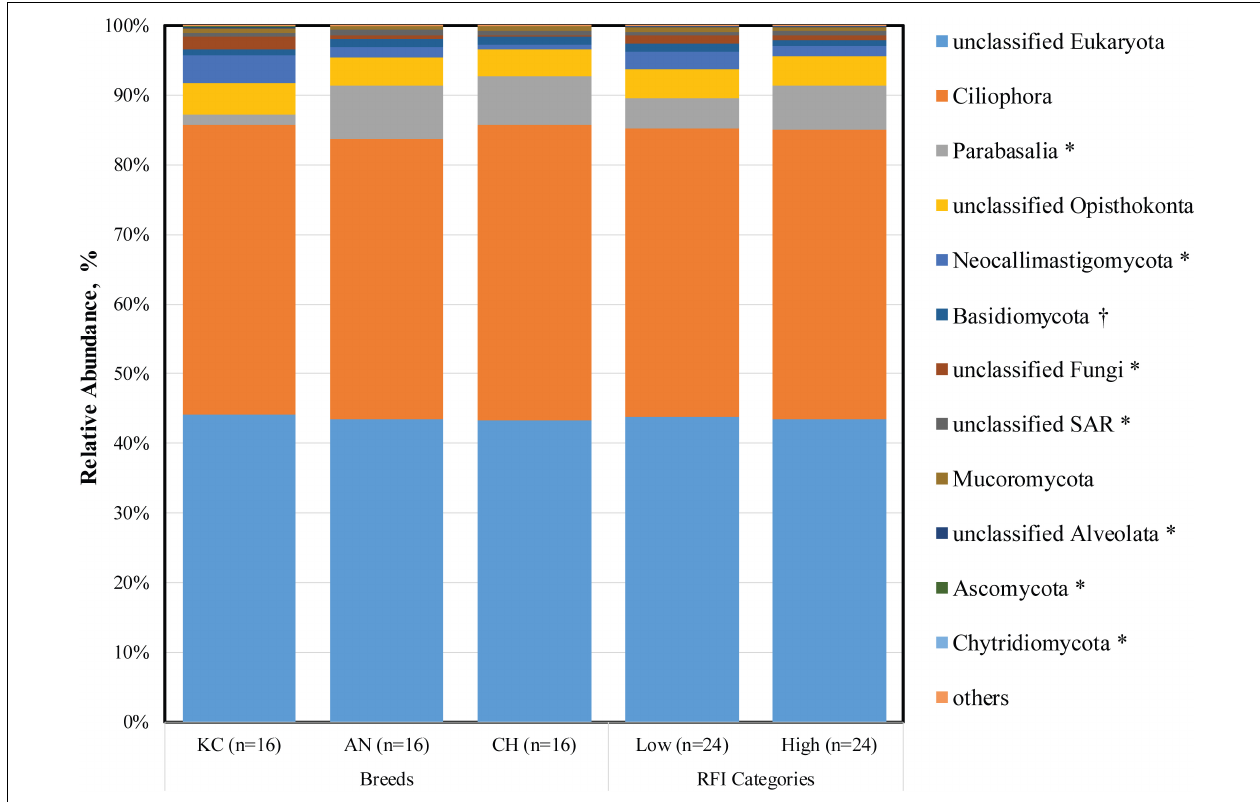
FIGURE 1 | Active rumen eukaryotic composition at the phylum level in beef cattle of three breeds and with divergent residual feed intake (RFI). Taxa name with asterisk (*) represents significant breed effect ( P < 0.05), and taxa name with dagger ( † ) represents significant RFI effect ( P <